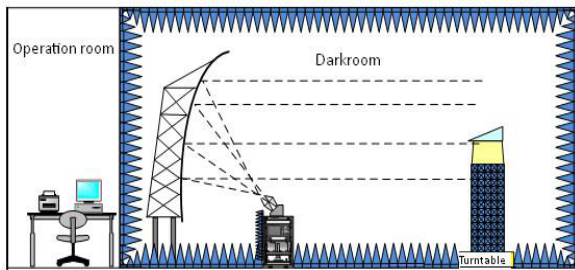
Figure 2: Diagrammatic representation of Compact